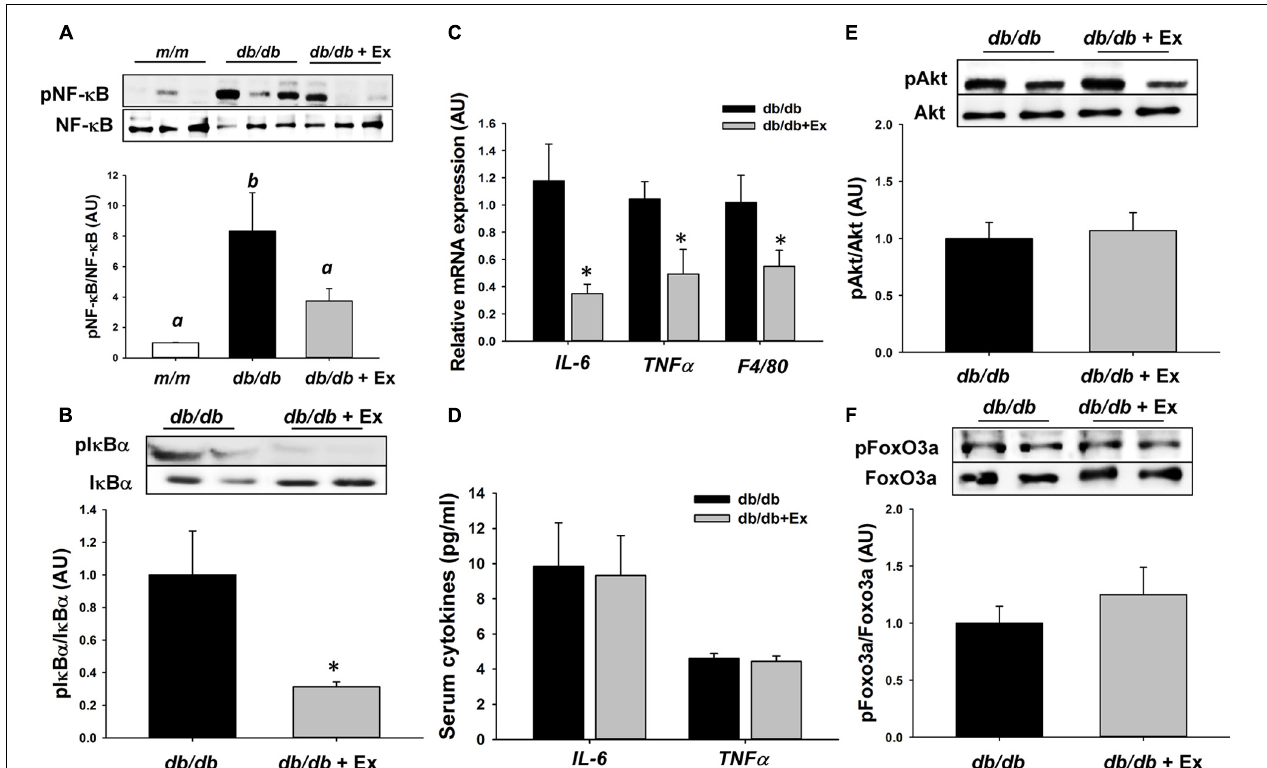
FIGURE 3 | Effect of moderate exercise training on protein expression, mRNA expression, and proinflammatory cytokines. Representative blots of NF- κ B, phospho-NF- κ B (Ser563), I κ B α , and phospho-I κ B α (Ser32), are shown (A,B) . The protein levels in gastrocnemius muscles are presented mean ± SEM ( n = 5/group). IL-6, TNF α , and F4/80 mRNA expression levels in gastrocnemius muscles are expressed as mean ratio to control after normalization with 18S mRNA levels. Fold differences were calculated using the (cid:49)(cid:49) C t method. Values presented are mean ± SEM ( C , n = 6–8/group, each in triplicate). Serum levels of IL-6 and TNF α ( D , n = 11–12/each group). Representative blots of Akt, phospho-Akt (Thr308), FoxO3a, and phospho-FoxO3a (Ser253) are shown (E,F) . The protein levels in gastrocnemius muscles are presented mean ± SEM ( n = 5–7/group). Significance ( P < 0.05) among groups is denoted by different letters. ∗ P < 0.05 vs. db/db